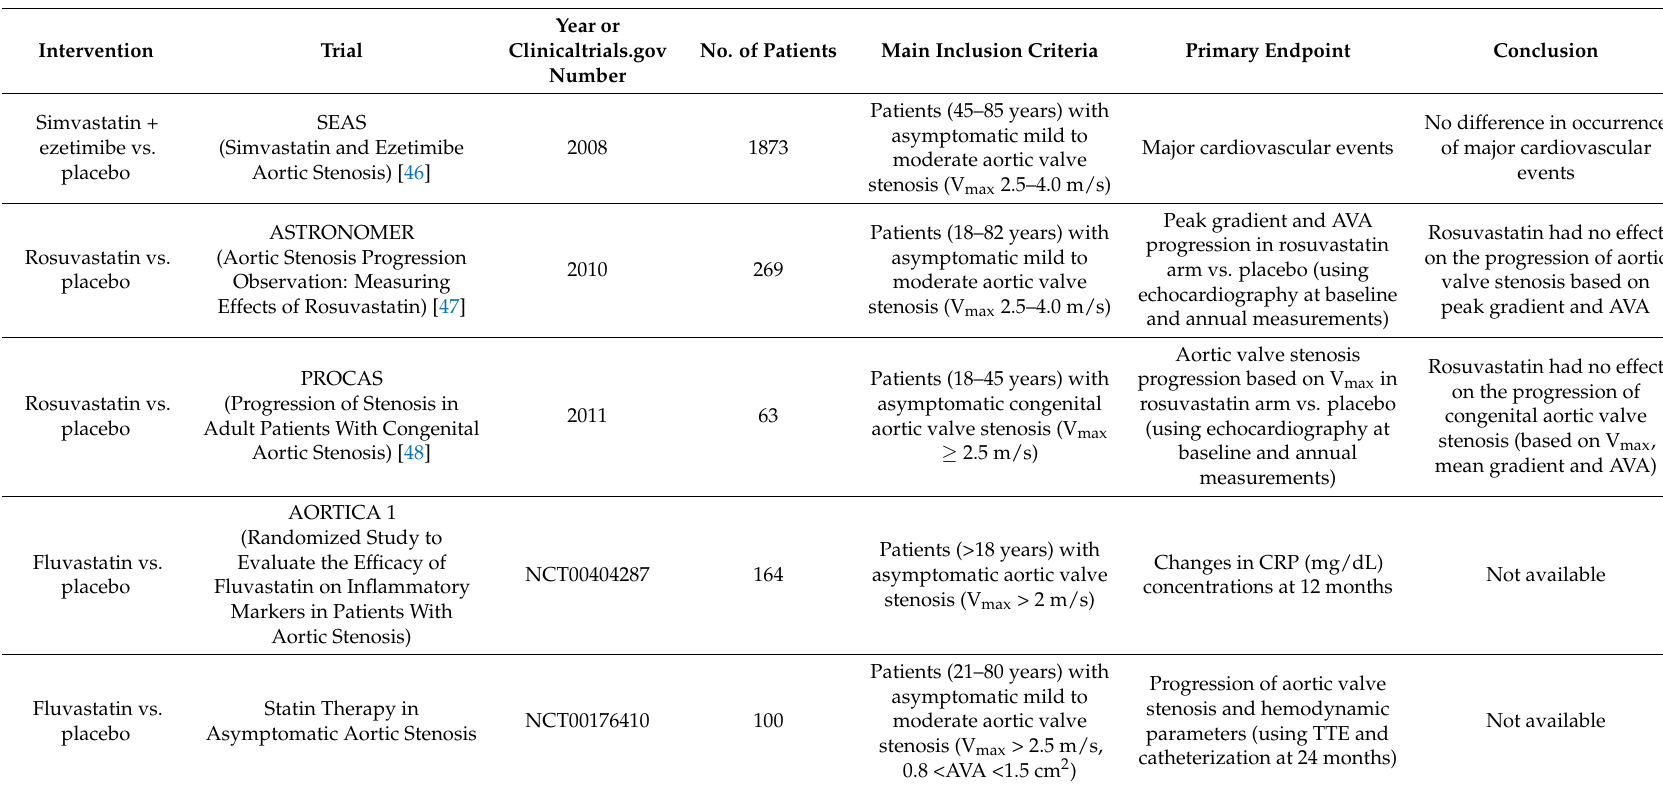
Table A1. Overview of randomized controlled trials performed with various pharmacological interventions with primary endpoints other than calcification in aortic valve